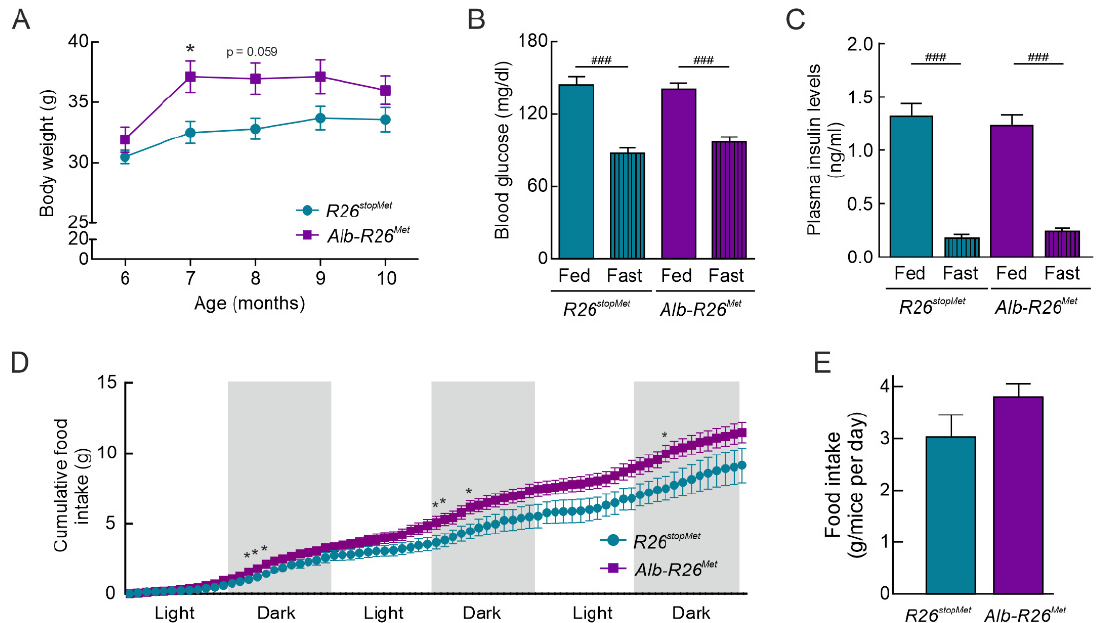
Figure 2. Alb-R26 Met mice present elevated body weight and food intake compared to R26 stopMet controls. ( A ) Body weight evolution and total body weight gain of R26 stopMet and Alb-R26 Met mice ( n = 10 and 19 mice per group, respectively). ( B ) Blood glucose levels (mg/dl) under fed and 16 h fasting conditions in R26 stopMet and Alb-R26 Met mice ( n = 9 and 19 mice per group, respectively). ( C ) Plasma insulin levels (ng/mL) in fed ( n = 4 and 14 mice per group, respectively) and 16 h fasted ( n = 6 and 8 mice per group, respectively) conditions. ( D ) Cumulative food intake (g) of R26 stopMet and Alb-R26 Met mice ( n = 6 and 10 mice per group, respectively). ( E ) Food intake (g) ( n = 6 and 10 mice per group, respectively). Blood glucose, plasma insulin, and food intake were measured at the end of the experiment and, therefore, in 10 months old mice. ( A – E ) Values are mean ± SEM. For ( A ) and ( D ), statistical analysis was performed by fitting a mixed model followed by a Bonferroni post hoc test. For ( B ), statistical analysis was performed by a two-way ANOVA followed by a Bonferroni post hoc test. For ( C ) and ( E ), statistical analysis was performed according to a Student’s t test. * p < 0.05, ** p